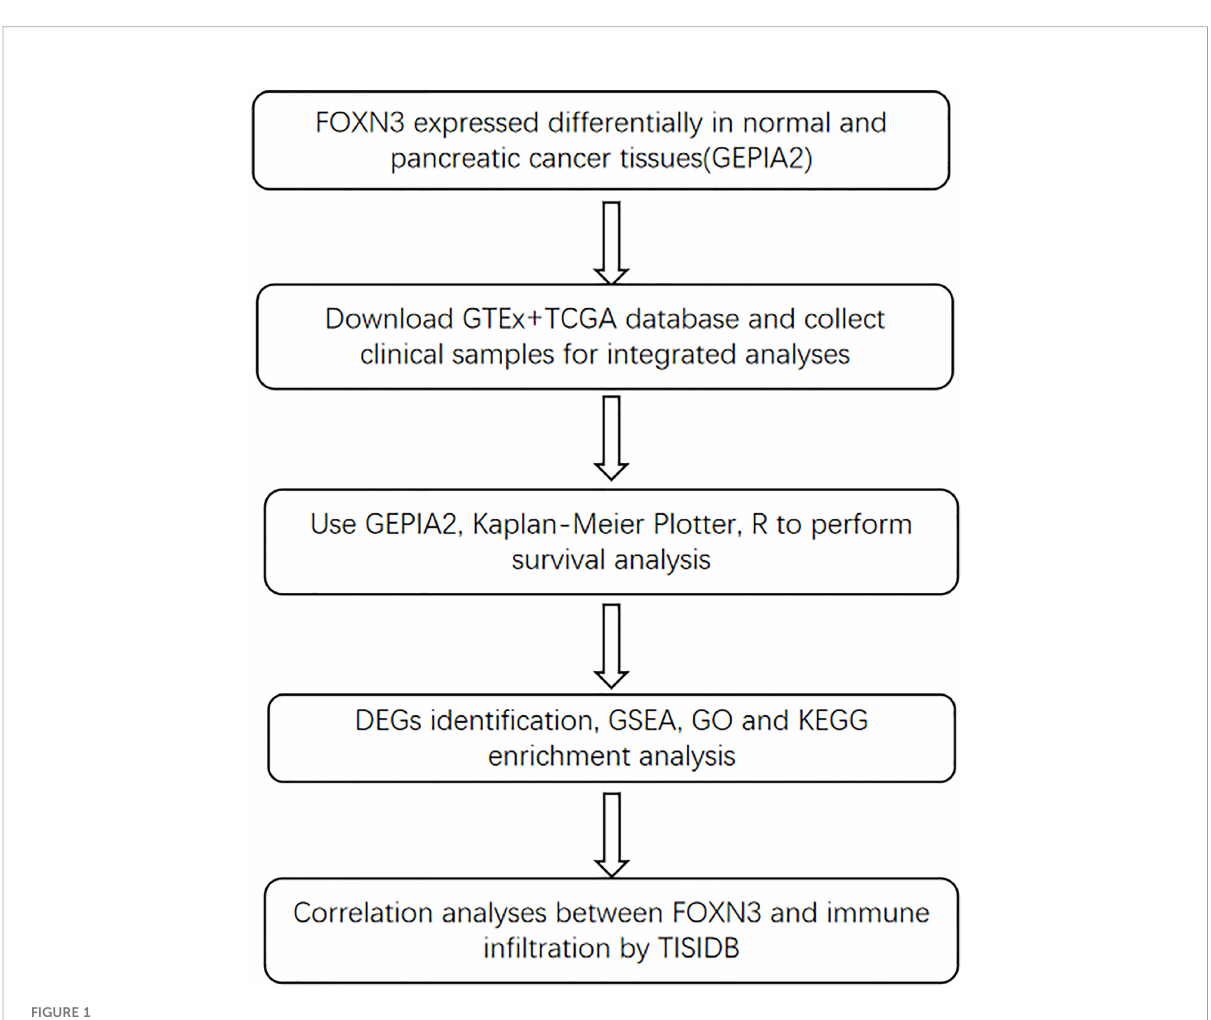
FIGURE 1 The work fl ow fl ow